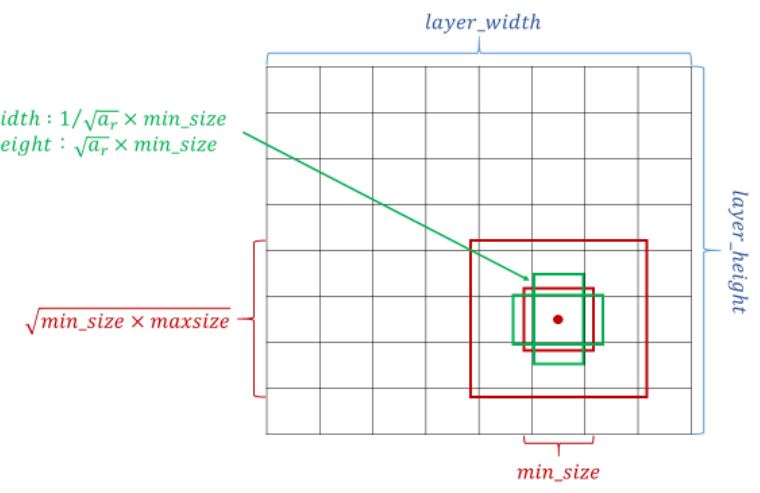
Figure 2. Schematic of the settings of the default box. Taking the midpoint of each point on the feature map as the center, a series of square prior frames with different sizes and the same center point was generated. With the square prior frame, the ground truth cannot be all square. If the square prior frame was used to predict the ground truth, the prediction effect could not be optimized. Therefore, in addition to the square prior frame, multiple rectangular prior frames needed to be added to match the ground truth and increase the model prediction effect.